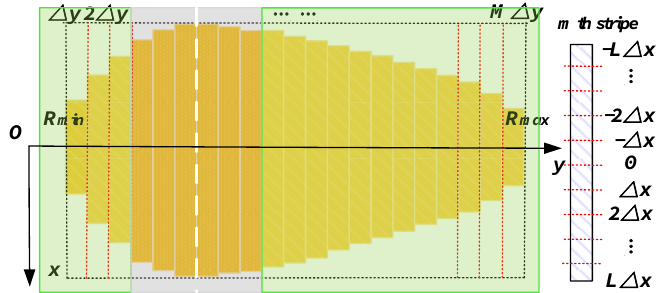
Figure 3. Dividing the radar coverage into several grids sized ∆ x × ∆ y .